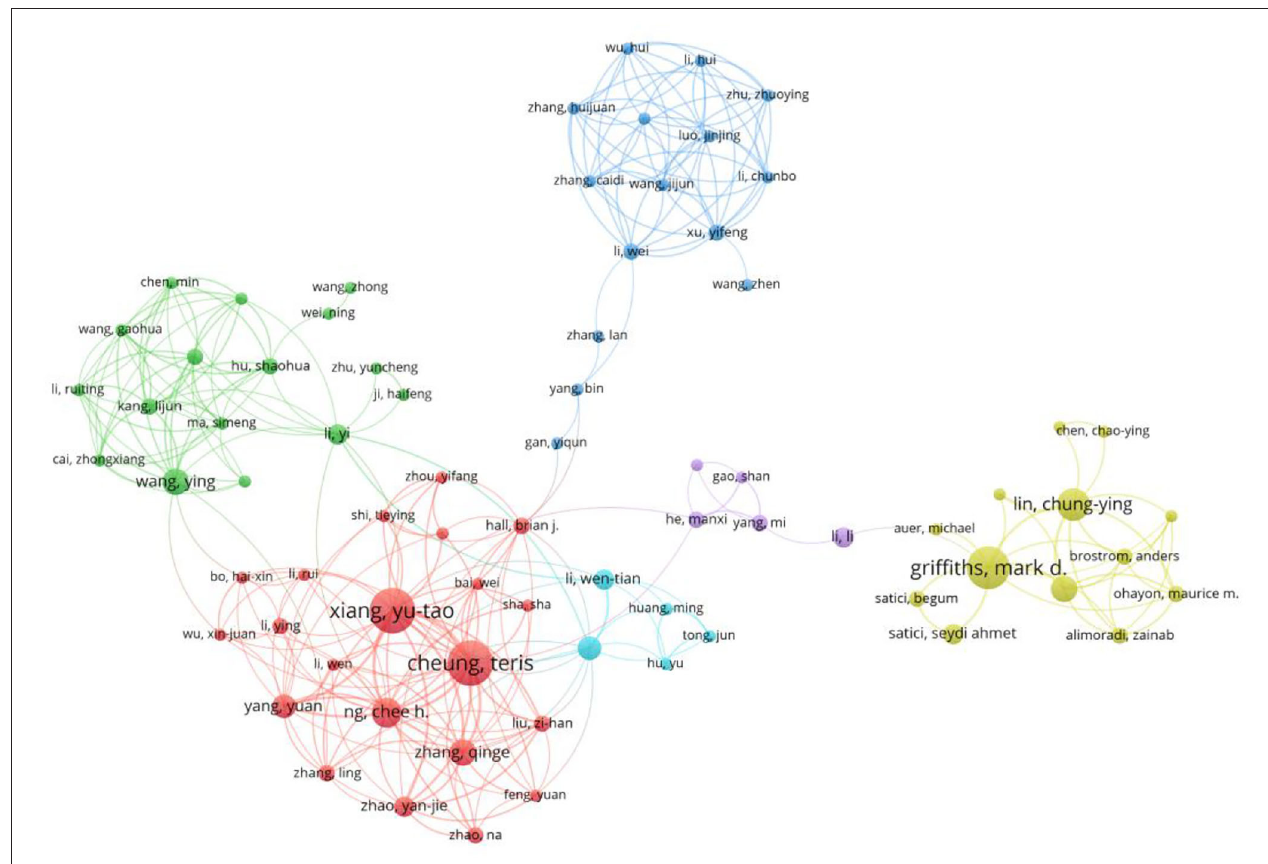
FIGURE 4 | Author co-occurrence